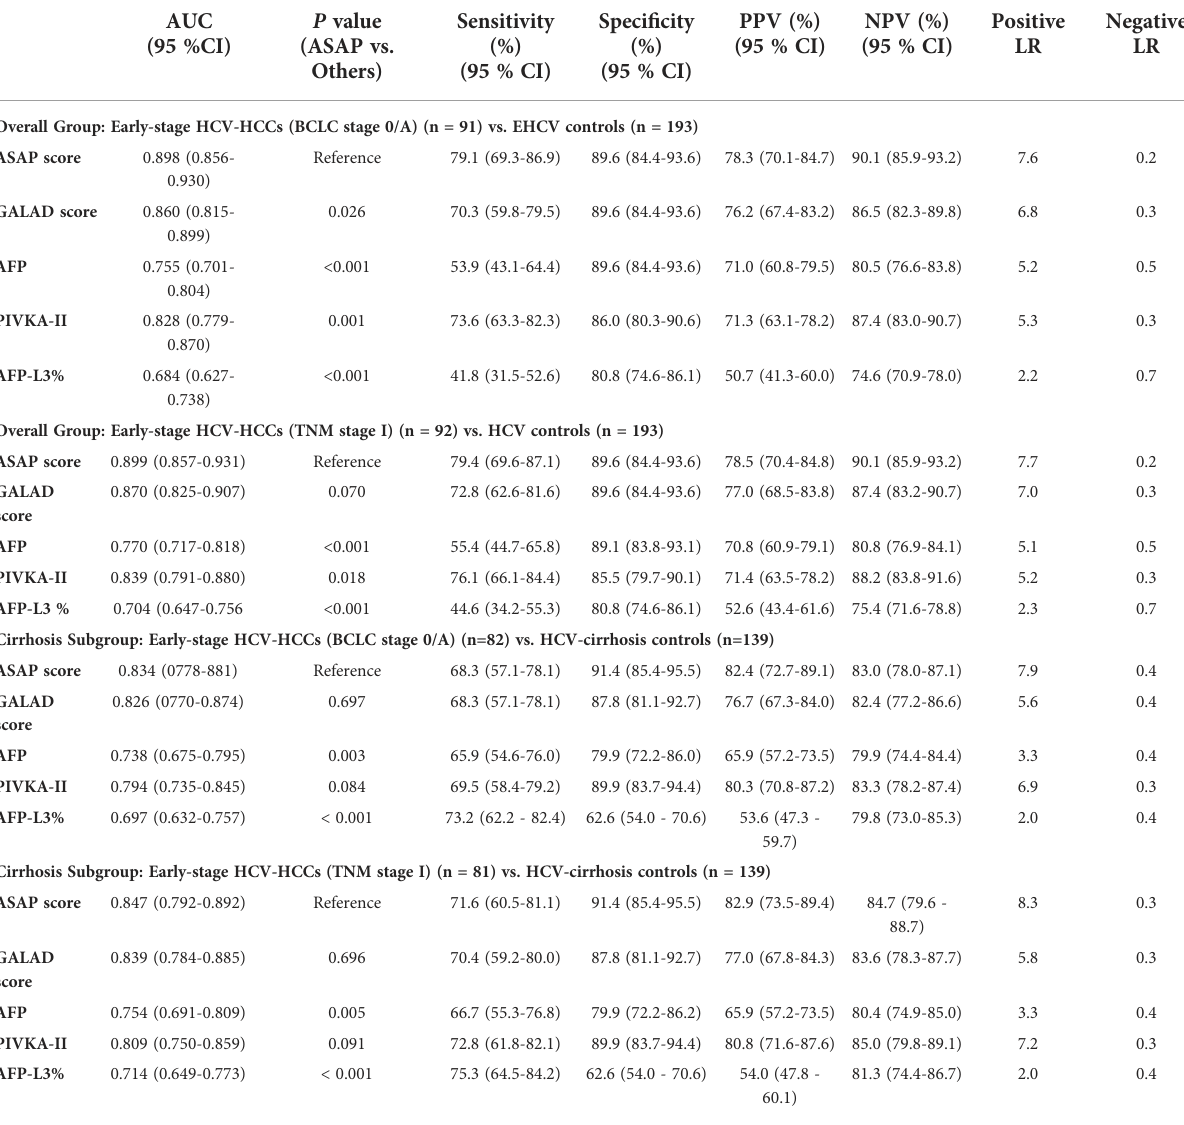
TABLE 3 Diagnostic performances of the ASAP score, the GALAD score, AFP, PIVKA-II, and AFP-L3% for detecting early-stage HCV-HCC in the overall group and the cirrhosis subgroup. P value AUC (95 %CI) (ASAP vs.